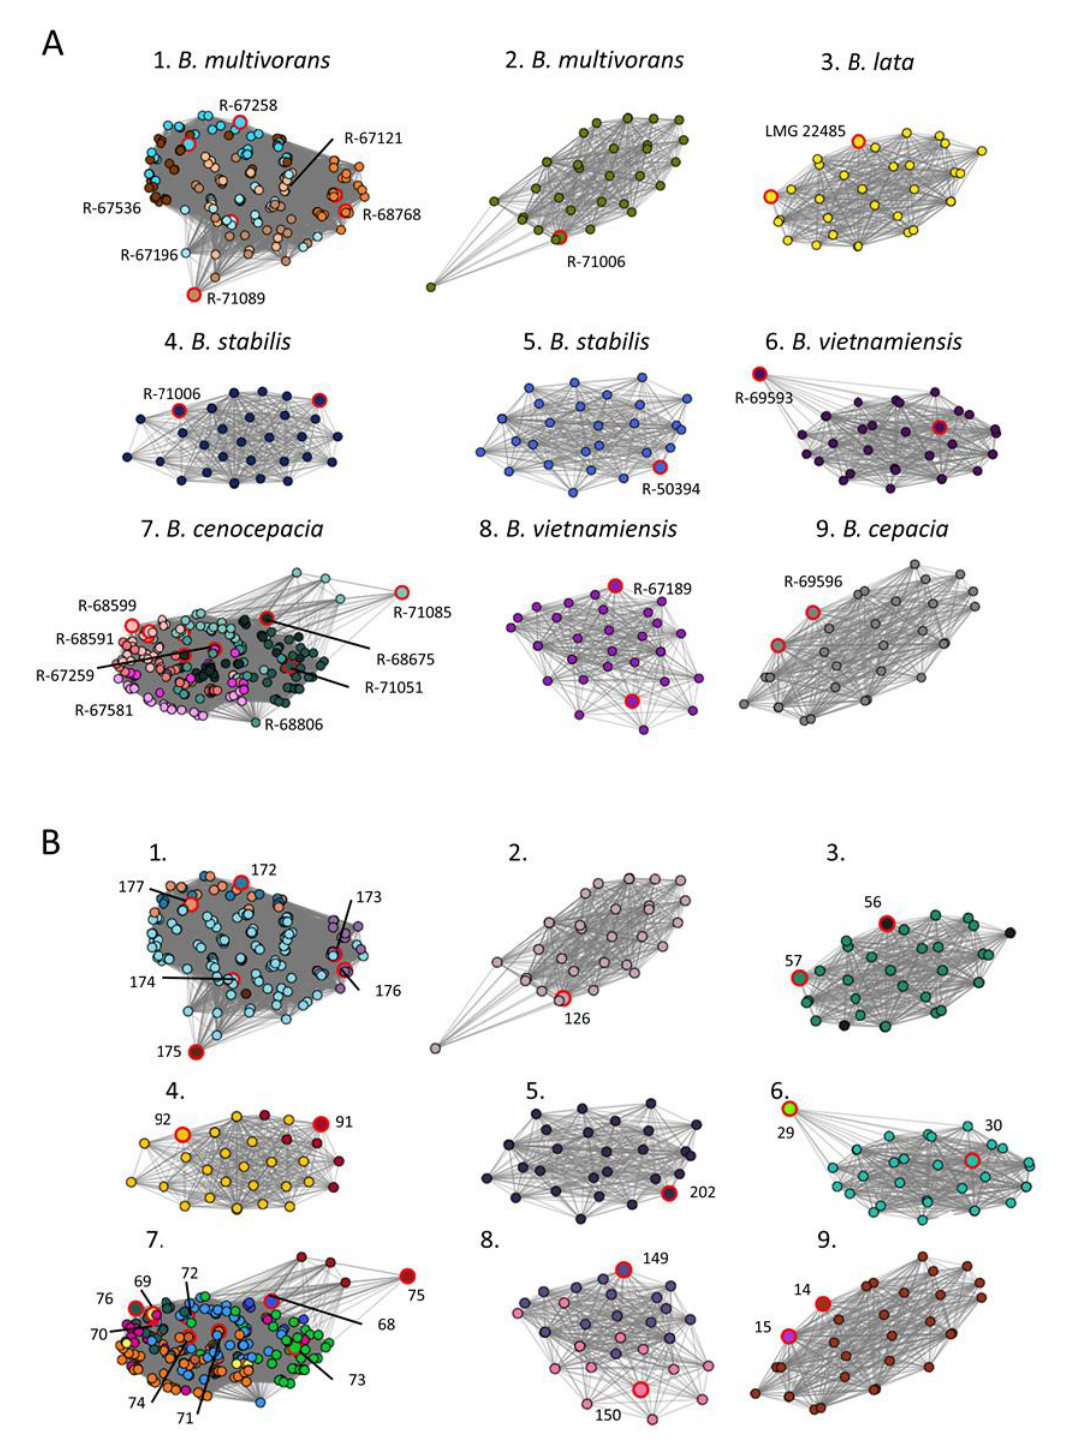
Figure 2. Network analysis on benchmark dataset containing 21 strains of six Burkholderia cepacia complex species. ( A ) Network analysis based on all zero USFs elements (edges) of the USF matrix, colored according to the strain number. ( B ) Network analysis based on all zero USFs elements (edges) of the USF matrix, colored accordingly to OIU number. The reference spectrum of each OIU is highlighted with large node sizes and red marking ( A , B ).